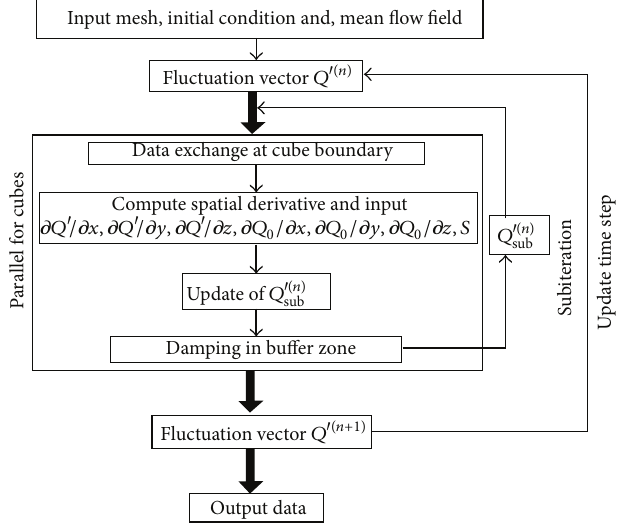
Figure 2: Computational algorithm of the linearized Euler equations (LEEs) solver.